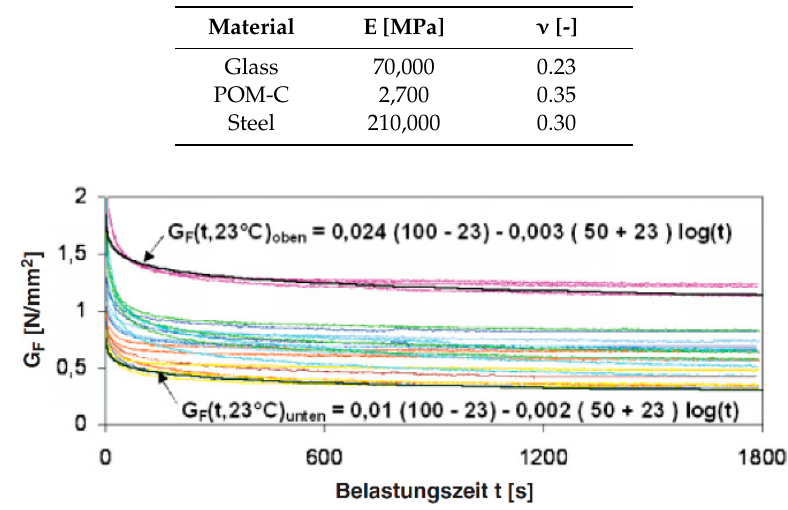
Figure 4. Range of the scatter of the G (23 °C, t) -curves (reproduced with permission from [11], Wiley, 2007).